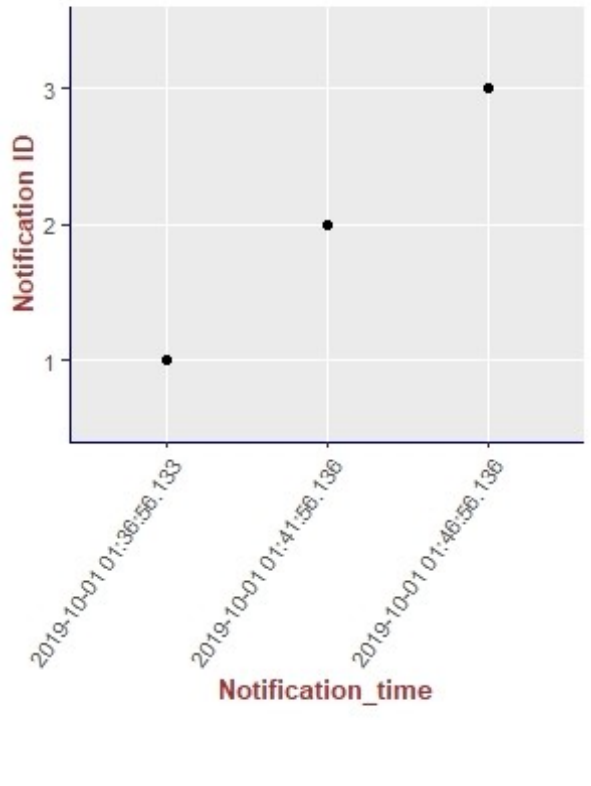
Figure 16. Illustration of the results of the delivery process related to all our